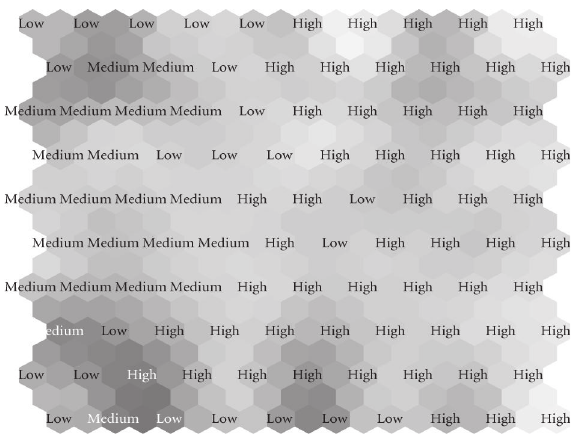
Figure 8: Trajectory of adware family ADW ALEXA on Informa- tion